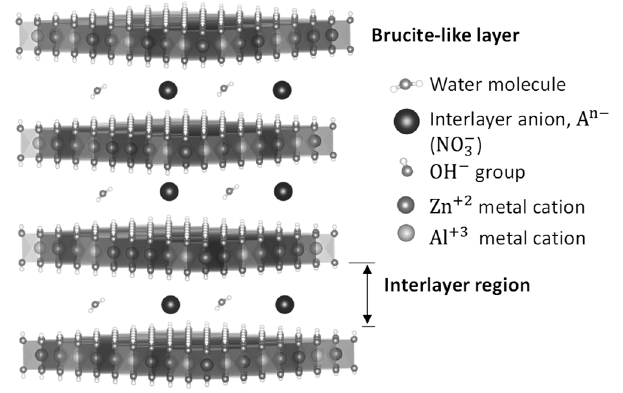
Figure 1. Schematic representation of the (Zn-Al-NO 3 ) LDH